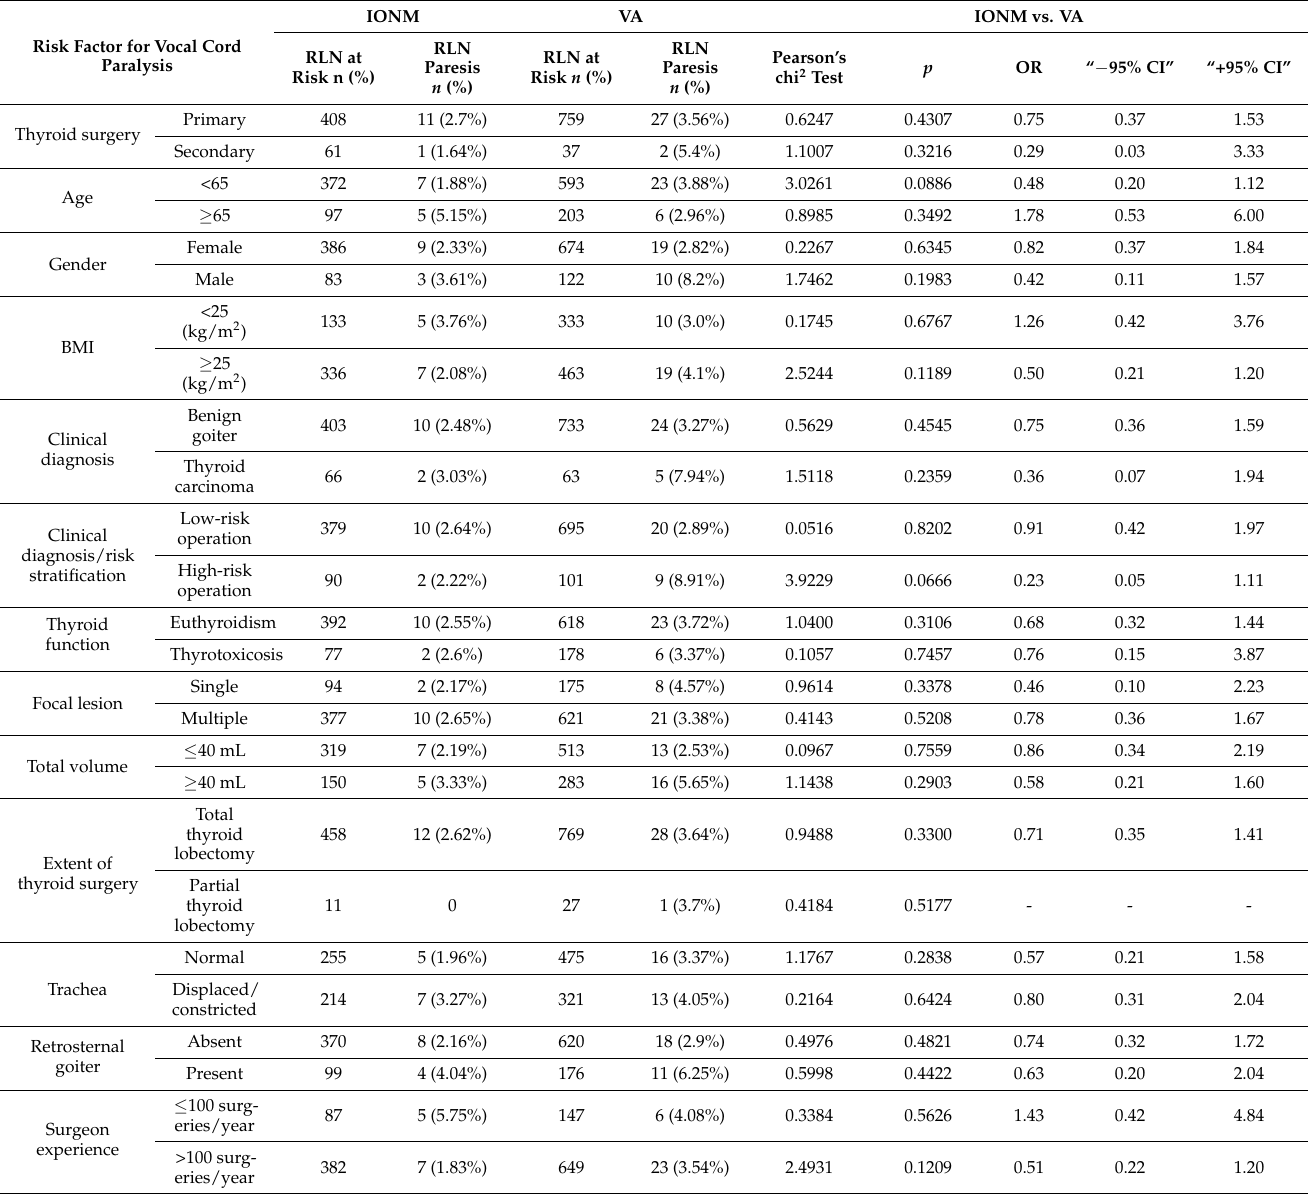
Table 4. Risk factors and vocal cord paralysis in thyroid operation with IONM vs. visual RLN identification alone—Pearson’s chi 2